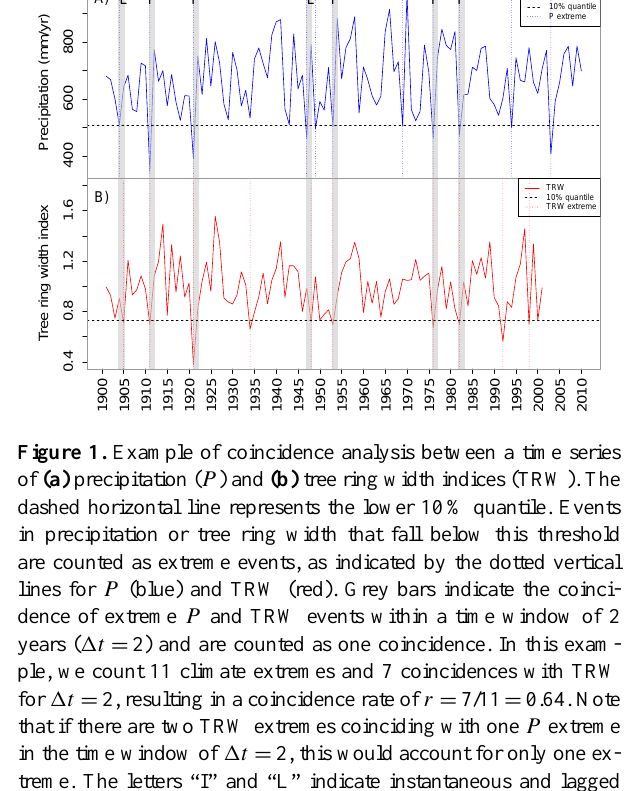
or combined P and T to obtain the coincidence rate r with 0 ≤ r ≤ 1 (0 if no coincidences occur and 1 if the maximum number of possible coincidences